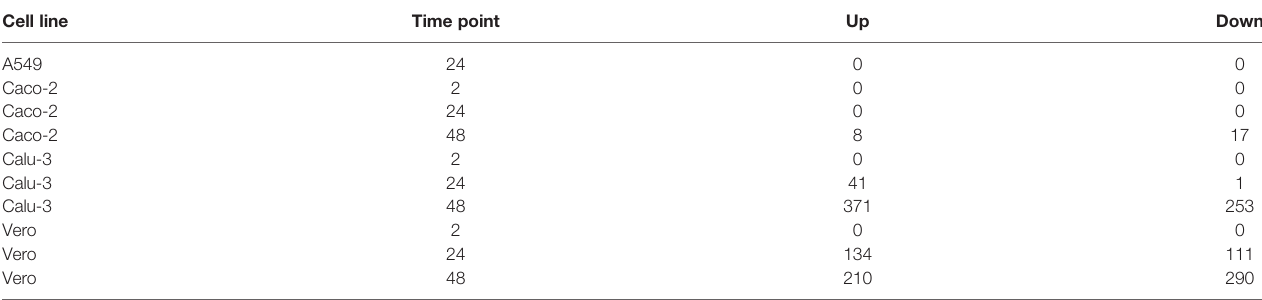
TABLE 2 | The number of signi fi cantly differentially expressed genes (padj < 0.05) between control and infected cells in A549, Caco-2, Calu-3 and Vero cells over 2, 24 and 48 hpi in direct cDNA datasets. Cell